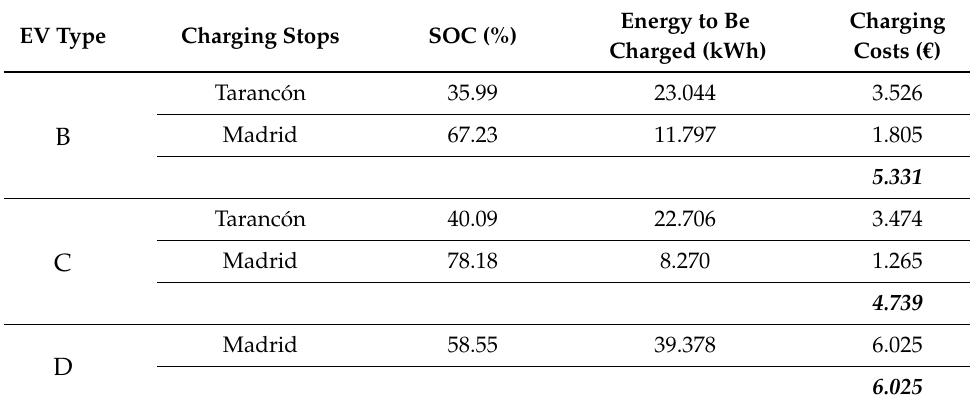
Table 4. Simulation results for the Cuenca–Madrid